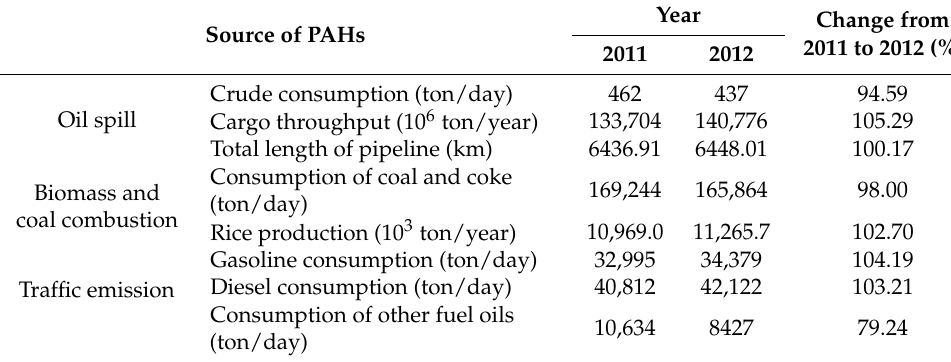
Table 2. PAHs related to human activities in 2011 and